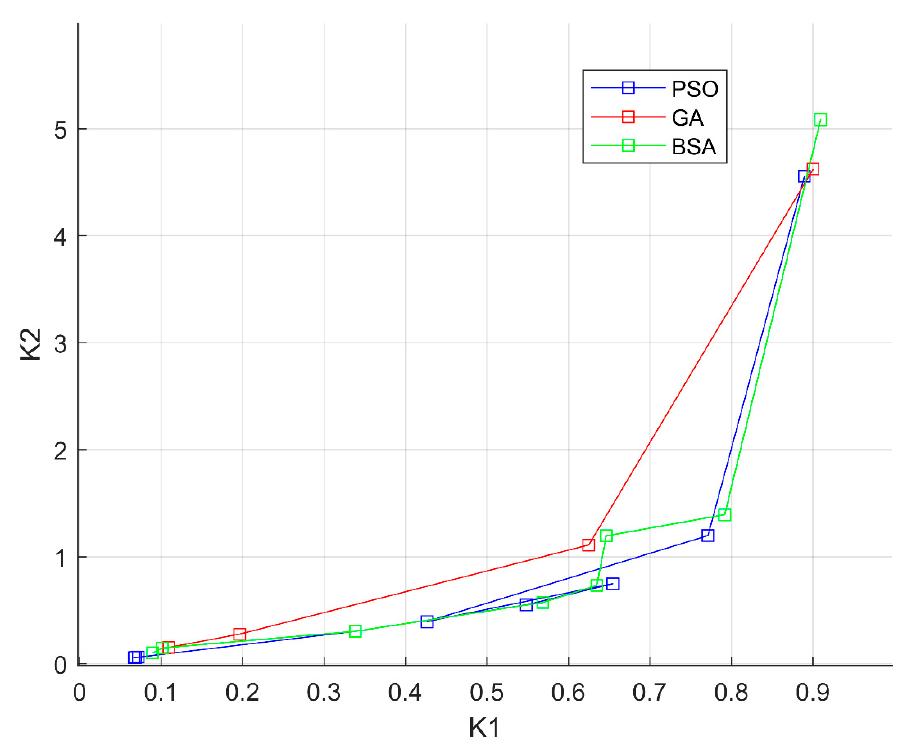
Figure 5. Pareto-optimal set for solving a problem by three methods.